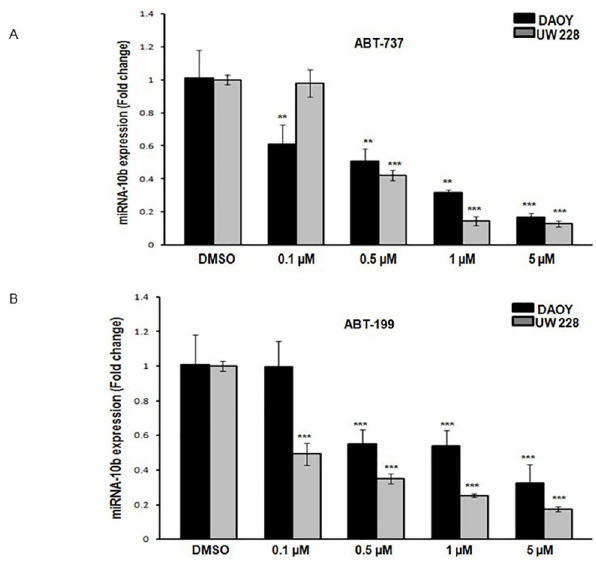
Fig 5. Down-regulation of miRNA-10b by BCL2 inhibitors is associated with the inhibition of proliferation by induction of apoptosis. Medulloblastoma cells were incubated with BCL2 inhibitors ABT- 737 and ABT-199 for 48 hours. DMSO 0.1% was used as a control treatment. Total RNA was extracted from DAOY and UW228 cells, and subjected to RT-PCR for the analysis of miRNA-10b expression under